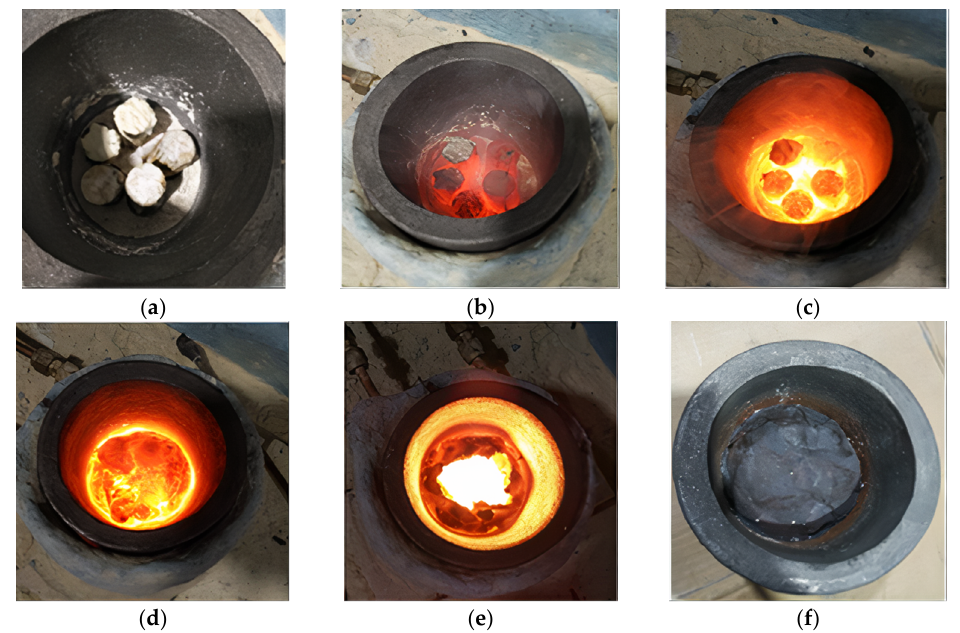
Figure 6. The whole process of melting and slag formation. ( a ) Prepared specimens and reagents were placed in a graphite crucible as an order of the reagents under the specimens; ( b ) to preheat the machine, the power is controlled within 2 kw; ( c ) gradually increase the power; ( d ) when the power reaches 15 kw, the metal is melted and slag is also formed; ( e ) liquid metal can be seen after breaking the solidified slag cover; ( f ) picture after